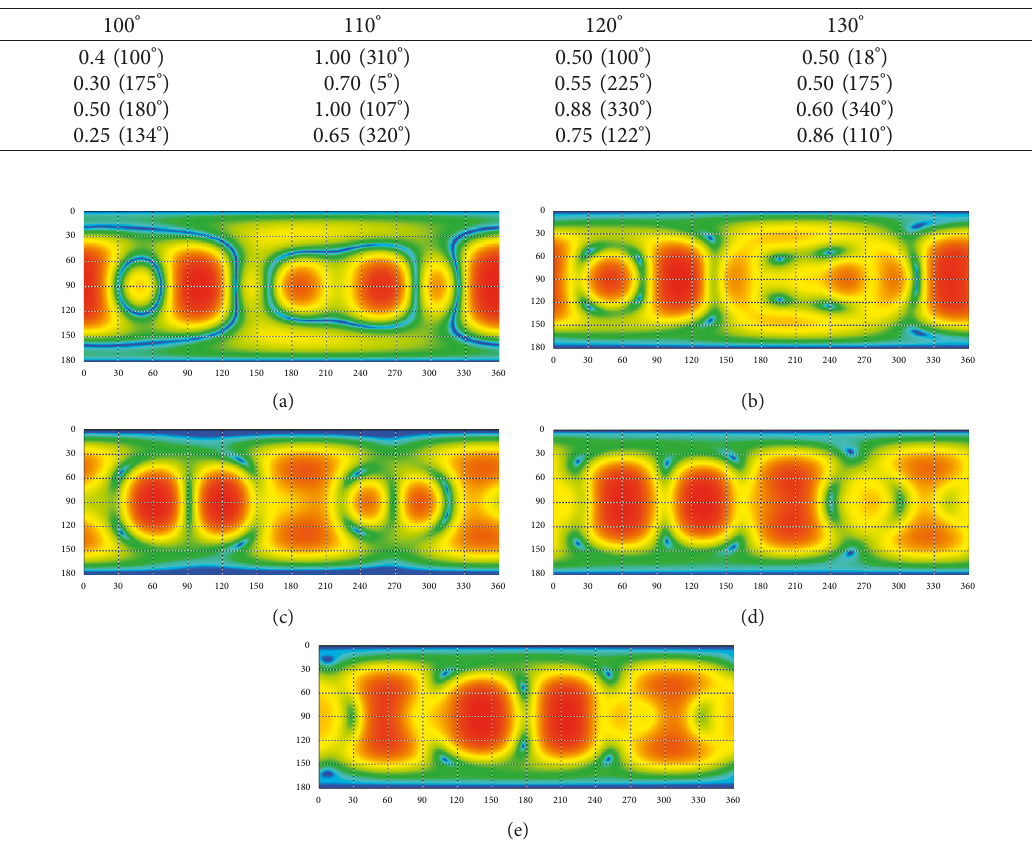
n, for each dipole element.